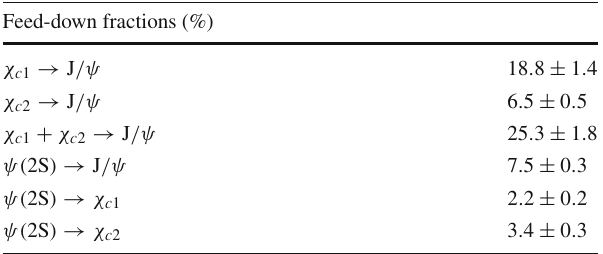
Table 3 p T / M -averaged values of the feed-down fractions, as deter- mined in the 1 β global-fit analysis. Virtually identical values are obtained in the 4 β fit option, for p T / M = 5. The derived direct J /ψ fraction is ( 67 . 2 ± 1 . 9 ) %